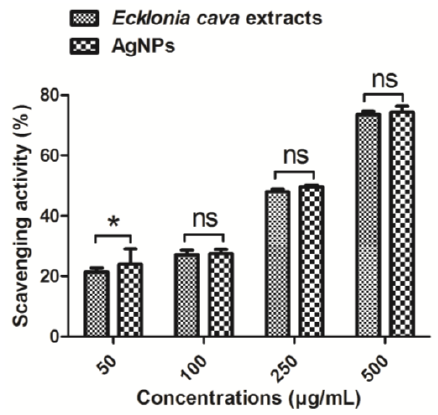
Figure 9. 1,1-diphenyl-2-picrylhydrazyl (DPPH) radical scavenging activity of Ecklonia cava extract and biosynthesized AgNPs. (ns: non-significant; * p < 0.05).